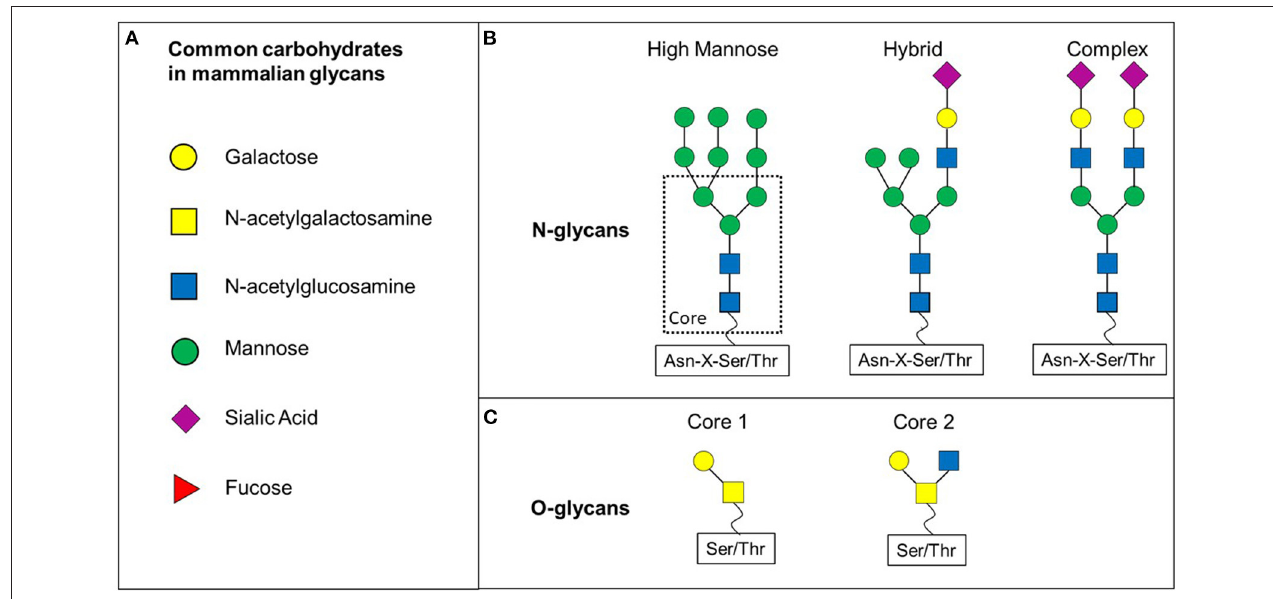
FIGURE 1 | N- and O-glycan differ in their core structure. (A) Various carbohydrates are making up mammalian glycans. (B) N-glycans share a common core structure. The carbohydrates added to the core structure define the three subtypes of N-glycans: high-mannose, hybrid and complex. (C) O-glycans discussed in this review are based on core 1 or core 2